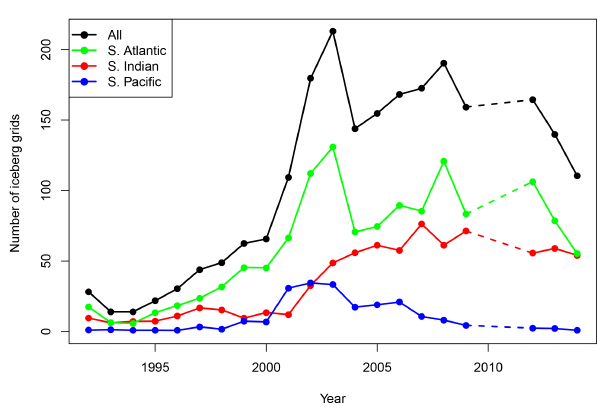
Figure 11. Temporal trend large icebergs: mean annual number grids occupied by large iceberg